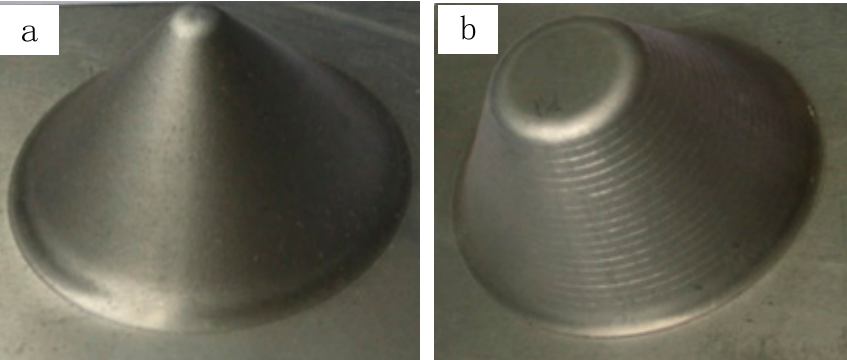
Figure 6. Experimental molded parts: ( a ) the specimen with forming angles of 45 ◦ and ( b ) the specimen with forming angles of 58 ◦ . Table 1. Conditions of the forming experiment.